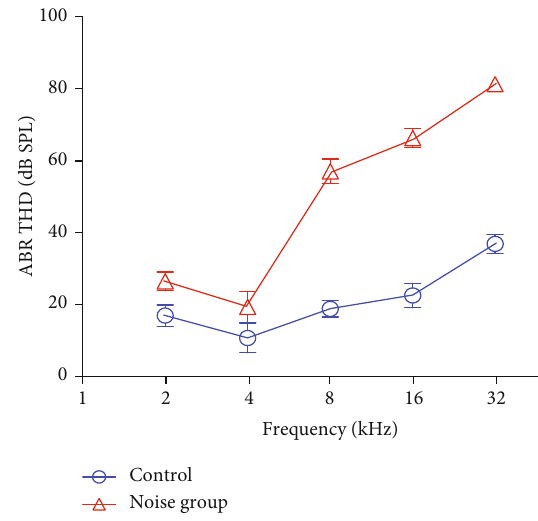
Figure 1: Thresholds of auditory brainstem response (ABR) measured from rats in the control group ( n = 4 ) and the noise group ( n = 4 ). The mean ABR thresholds of the noise group were signi fi cantly higher than those of the control group at 8-32 kHz, not at 2-4kHz.